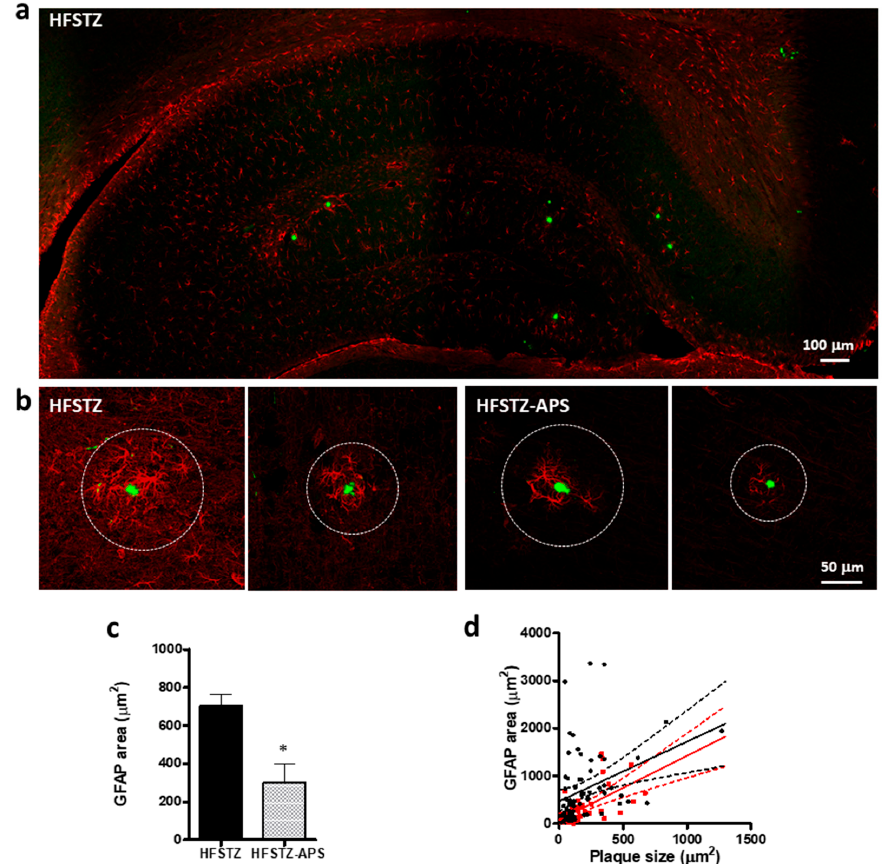
Figure 6. APS ameliorated HFSTZ-augmented activation of astrocytes in the vicinity of plaques. APP/PS1 mice were treated with HFSTZ ( n = 4) or HFSTZ-APS ( n = 4). ( a ) Representative confocal images of plaque (green) and the plaque-associated astrocytes immunostained with anti-GFAP (red) antibody were shown. Scale bar, 100 μ m; ( b ) Representative confocal images of two selected plaques (green) surrounded by GFAP-positive astrocytes (red) in HFSTZ and HFSTZ-APS mice. Scale bar, 50 μ m; ( c ) GFAP-positive astrocyte area in the dotted circle indicated in panel b (8 time diameter of the surrounded plaque) in the vicinity of plaques in HFSTZ and HFSTZ-APS mice. Data are shown as mean ± SEM. * p < 0.05, significant difference from HFSTZ group; ( d ) The correlation of plaque size and GFAP positive area was analyzed by a scatter plot from 72 and 21 plaques in HFSTZ (black) and HFSTZ-APS (red) mice, respectively. Solid lines are linear regression lines and dashed lines are 95% confidence intervals, R 2 = 0.13 for HFSTZ group and R 2 = 0.17 for HFSTZ-APS group. Ionized calcium-binding adaptor molecule-1 (Iba-1) was used as microglia markers. We observed that microglia directly contacted the plaques. APS diminished the immunoreactivity of the Iba-1 that was associated with plaque. (Figure 7a,b). Plaque size and Iba-1 fluorescence intensity was analyzed by a scatter plot of 57 plaques to reveal the change of the activated plaque-associated microglia after APS treatment. The result showed that the APS treatment diminished HFSTZ-activated plaque-associated microglia (Figure 7c). Linear regression for HFSTZ group is y = 0.04 x + 20.16, R 2 = 0.33, for HFSTZ-APS group is y = 0.01 x + 14.62, R 2 = 0.17 ( p = 0.30 for difference in slops; p < 0.01 for difference in intercept), suggesting that the effect is plaque size-independent.